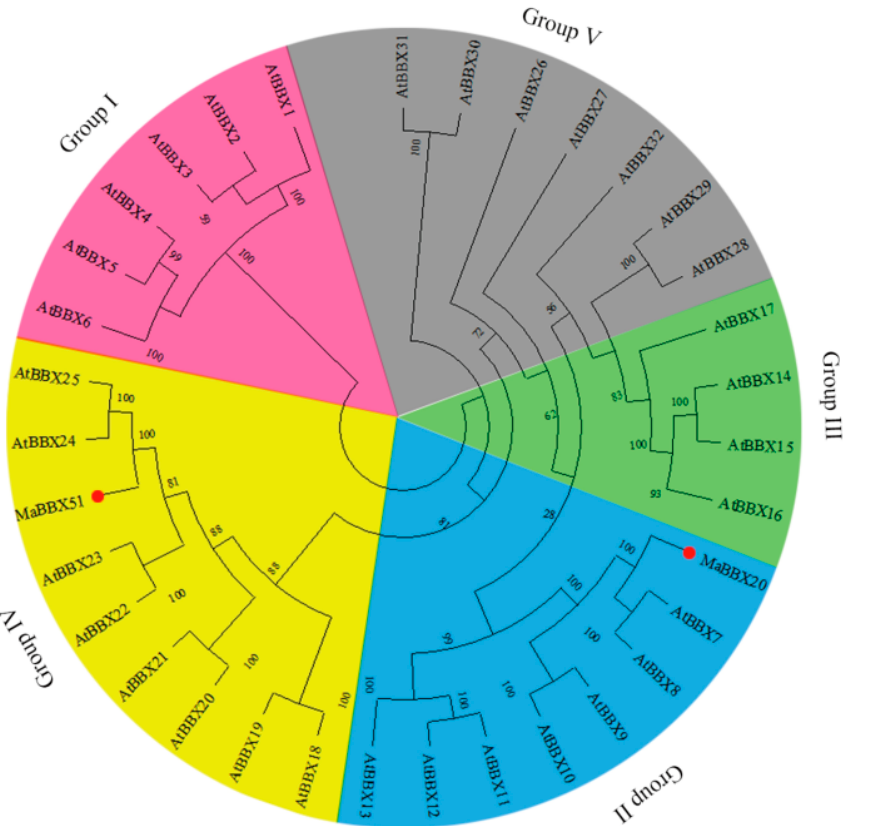
Figure 2. Phylogenetic analysis of MaBBX20, MaBBX51, and 32 A. thaliana BBX transcription factors. The neighbour-joining phylogenetic tree was constructed using the MEGAX software. Numbers next to each branch represent the bootstrap values of 1000 replicates. MaBBX20 and MaBBX51 are marked by red dots. Five subfamilies (I to V) are indicated in pink, blue, green, yellow, and grey. GenBank accession numbers for all proteins are listed in Supplementary Table S2.